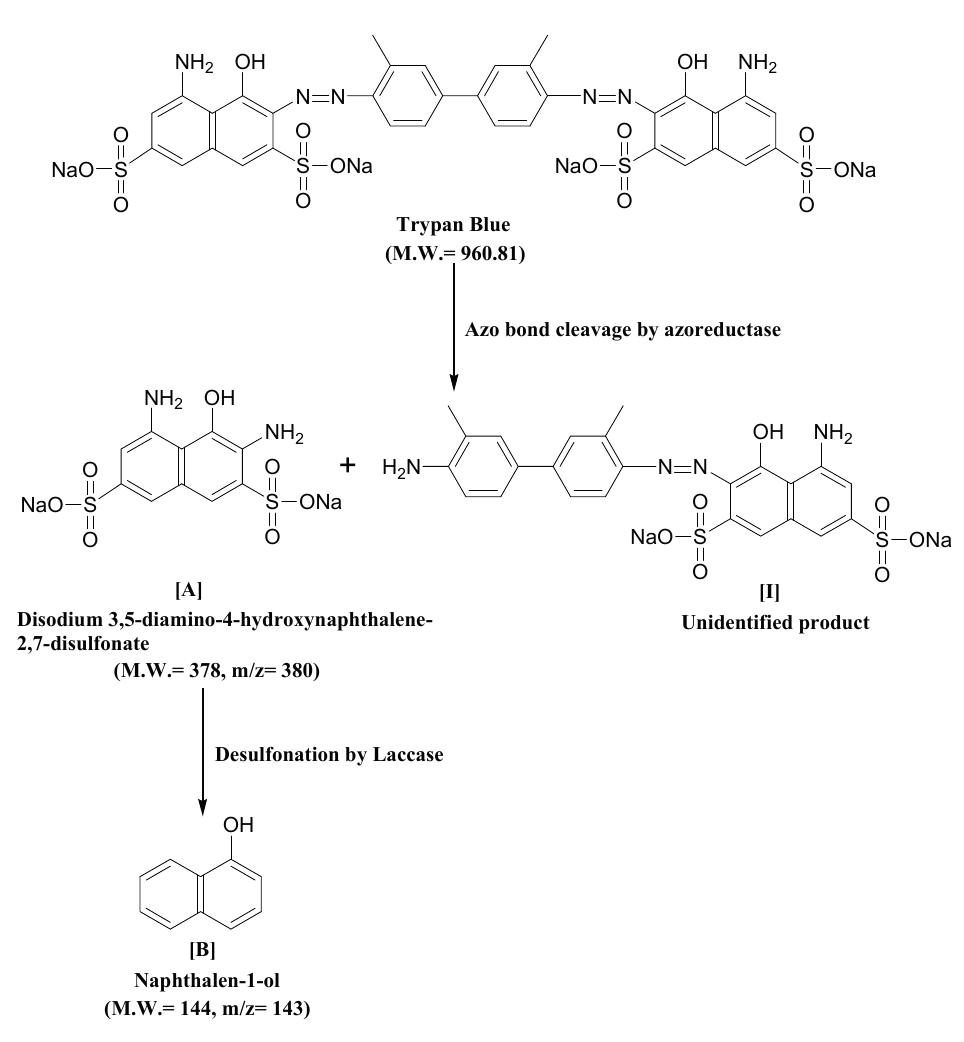
Figure 8. Possible degradation mechanism of Trypan Blue by the microbial consortium based on the GC-MS data and enzyme